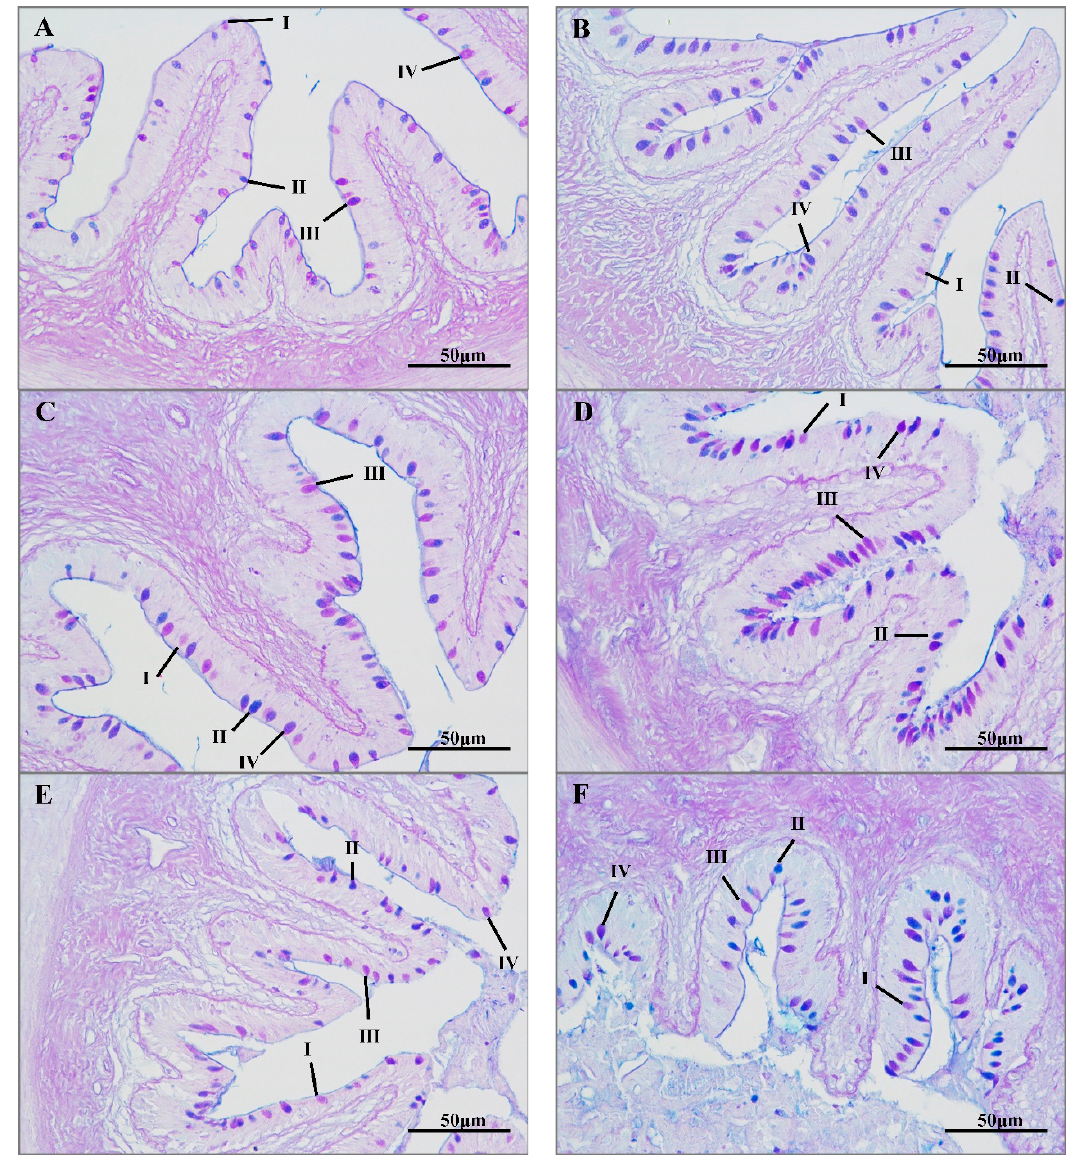
Figure 2. Alcian blue-periodic acid-Schiff staining (AB-PAS) of hybrid yellow catfish intestine under transport stress. Intestine mucous cells at different transport times 0 h ( A ); 2 h ( B ); 4 h ( C ); 8 h ( D ); 16 h( E ); 96 h recovery group( F ). Ⅰ , Ⅱ , III and Ⅳ represent different mucous cell types.